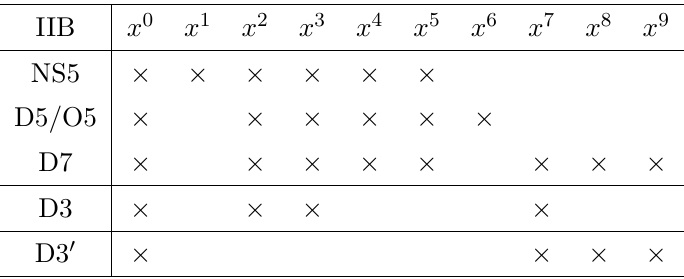
Table 2. The brane configuration for the circle compactification of 6d N = (1 , 0) SO( N c ) theories with N f = N c − 8 flavors. Note that a generic ( p, q ) 5-brane is depicted as line in the ( x 1 , x 6 ) plane with slope determined by p, q . Besides D7-branes, there may also be [ p, q ] 7-branes, on which ( p, q ) 5-branes can end. The codimension 2 defect is realized by the D3-brane; while the D 3 0 -brane introduces a codimension 4 defect.